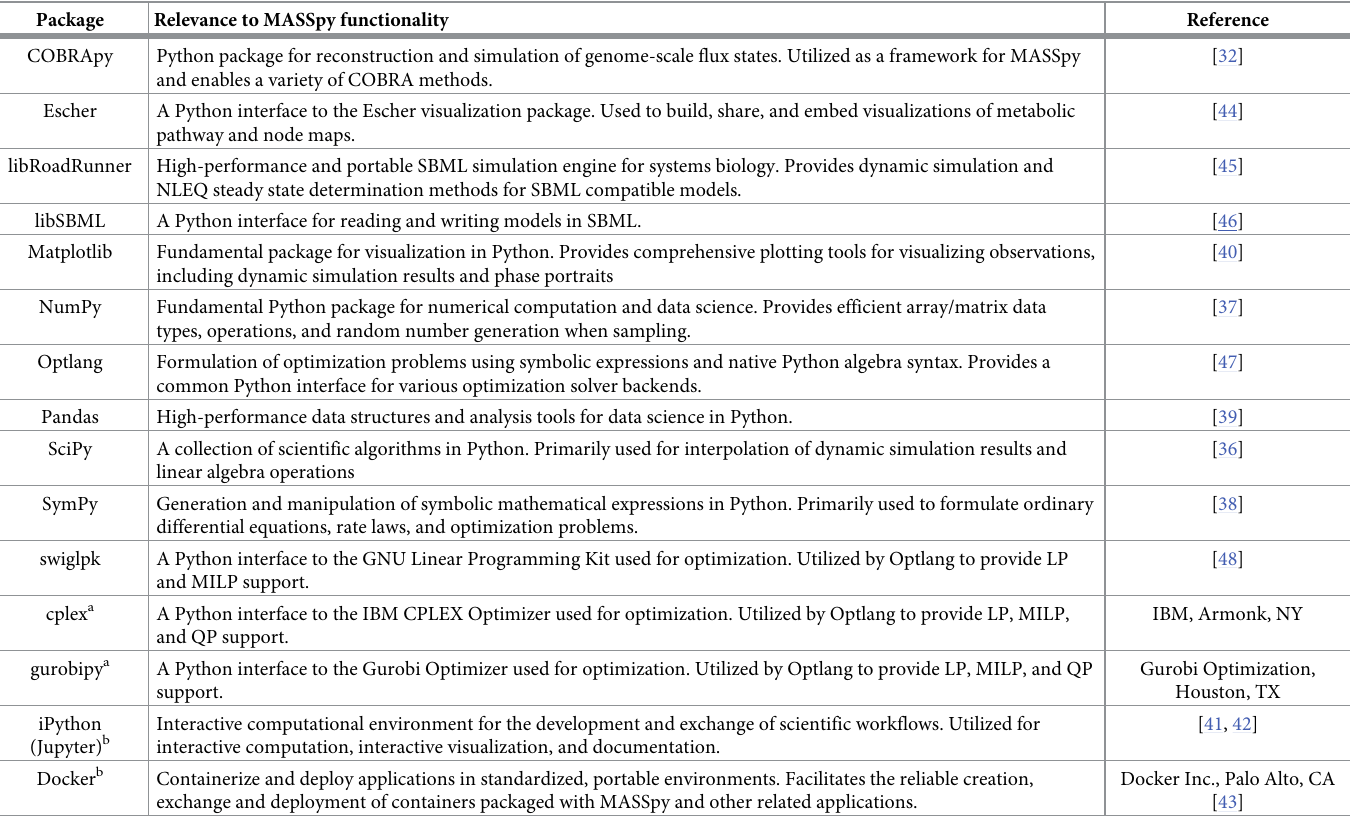
Table 1. Overview of select scientific software with relevance to MASSpy functionality.